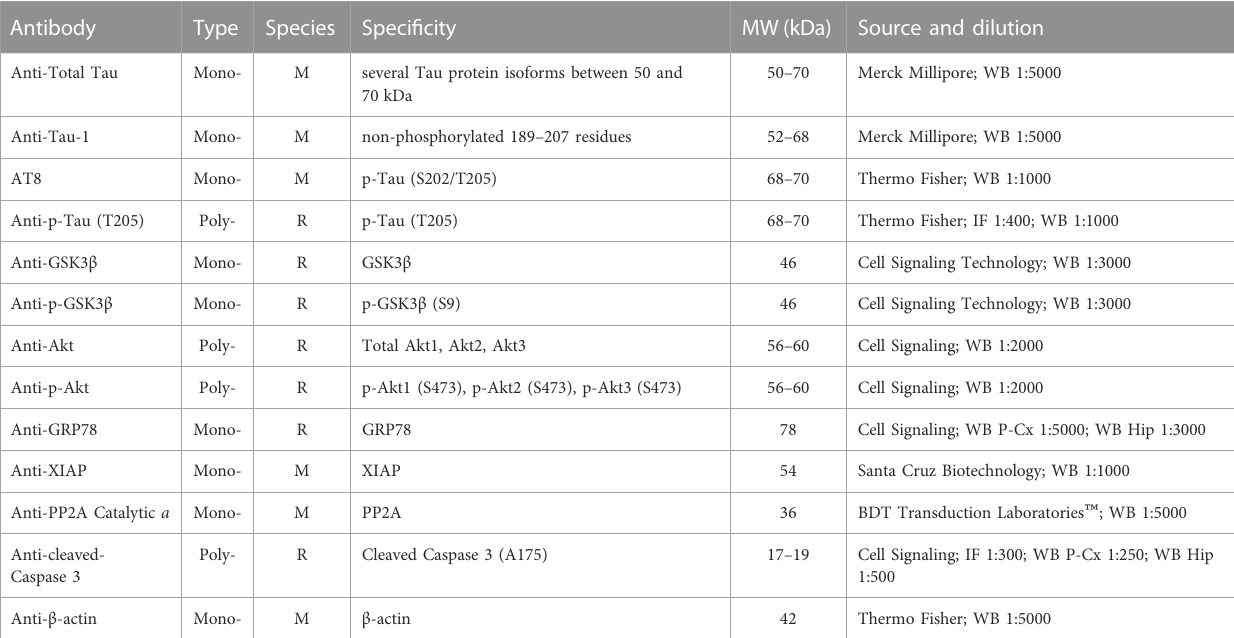
TABLE 1 Primary antibodies employed in this